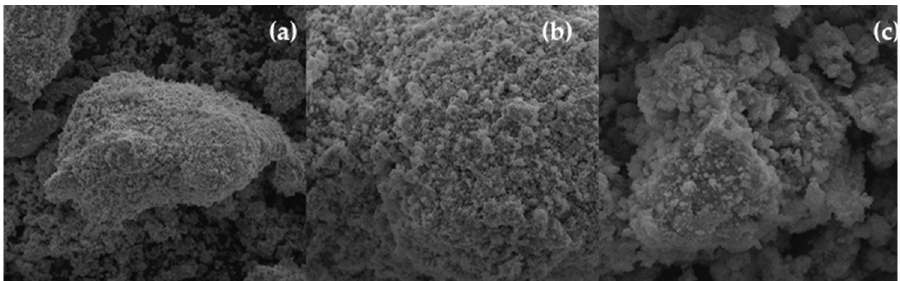
Figure 7. SEM of red mud pellets after calcination. MAG: 833 × ( a ); MAG: 3.33 k× ( b ); and MAG: 8.33 k× ( c ).